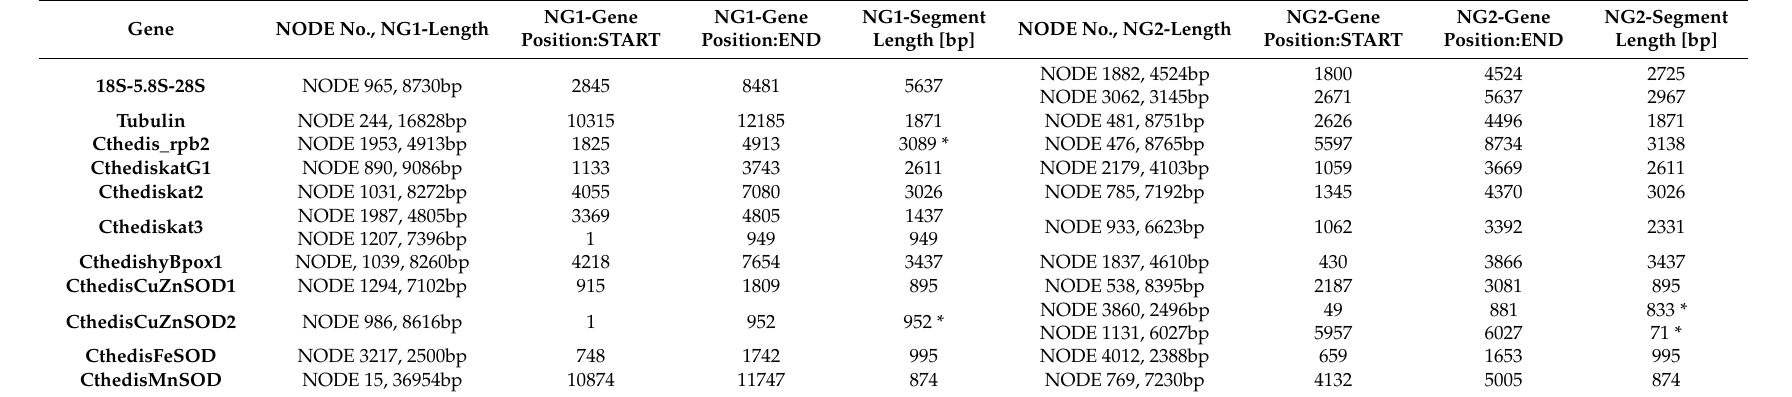
Table 1. List of important genes (either barcode-specific or antioxidant-coding) detected in the genome of Chaetomium thermophilum var. dissitum from the genome project